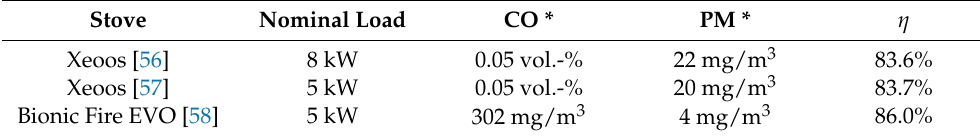
Table 2. Official type test results of stoves featuring the bottom-up combustion principle. Stove Nominal Load CO * PM * η Xeoos [56] 8 kW 0.05 vol.-% 22 mg/m 3 83.6% Xeoos [57] 5 kW 0.05 vol.-% 20 mg/m 3 83.7% 5 kW 302 mg/m 3 4 mg/m 3 86.0%